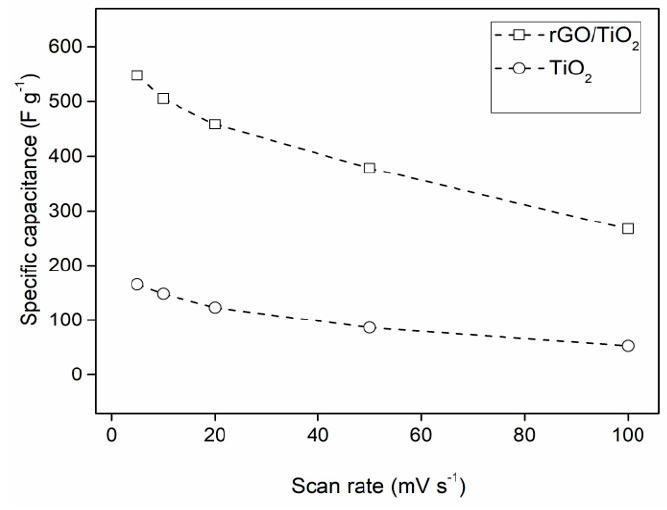
Figure 5. The relationship between scan rate and specific capacitance.